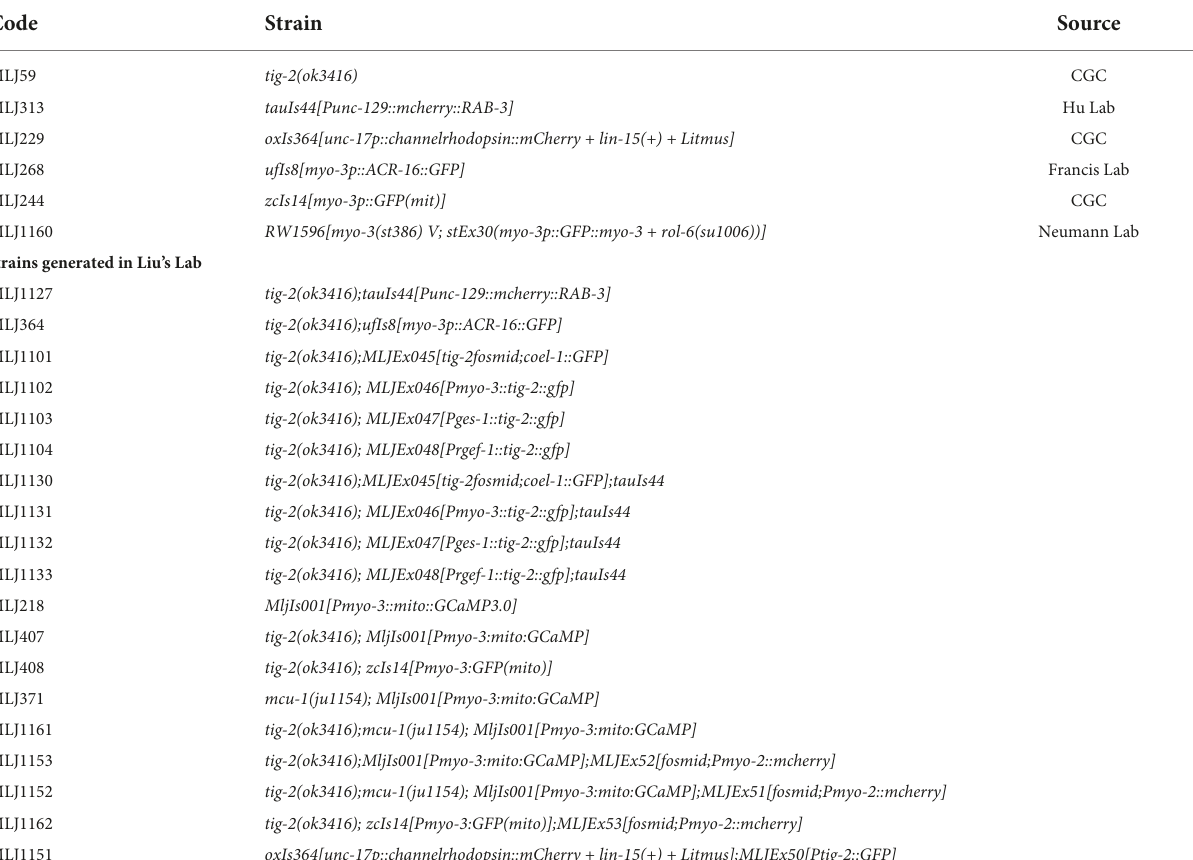
TABLE 1 Worm strains used in this